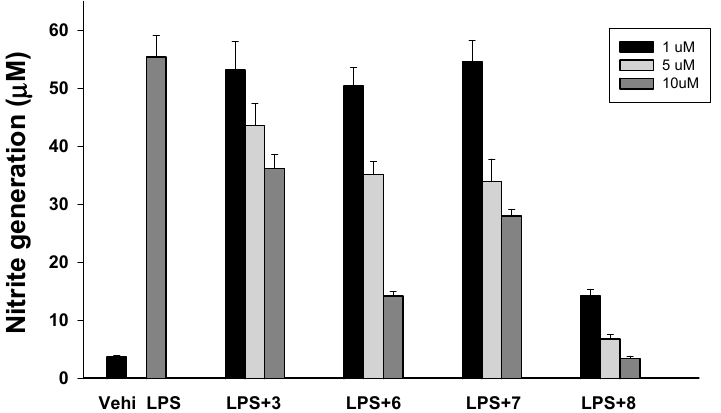
Figure 5. Suppression of NO production in lipopolysaccharide (LPS–treated BV2 cells. The cells were treated with 1 µg/mL of LPS only or LPS plus different concentration (1, 5 and 10 µM) of compounds 3 and 6 – 8 at 37 °C for 24 h. At the end of incubation, 50 µL of the medium was taken to measure the nitrite production. All values represent the mean ± Standard Error (SE) of three-independent experiments performed in triplicate.